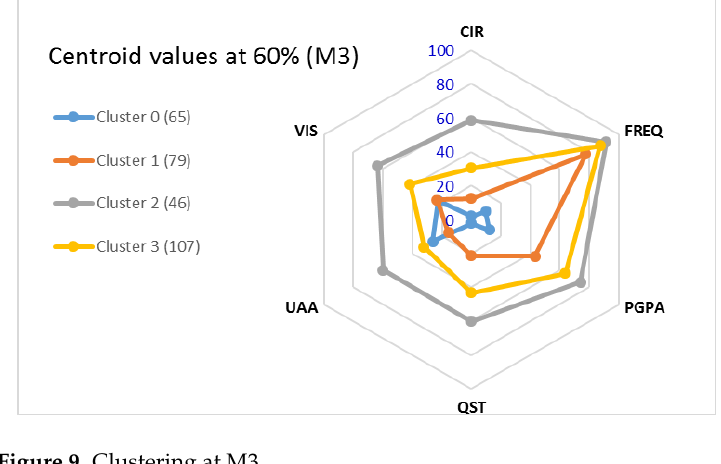
Figure 8. Clustering at M2.